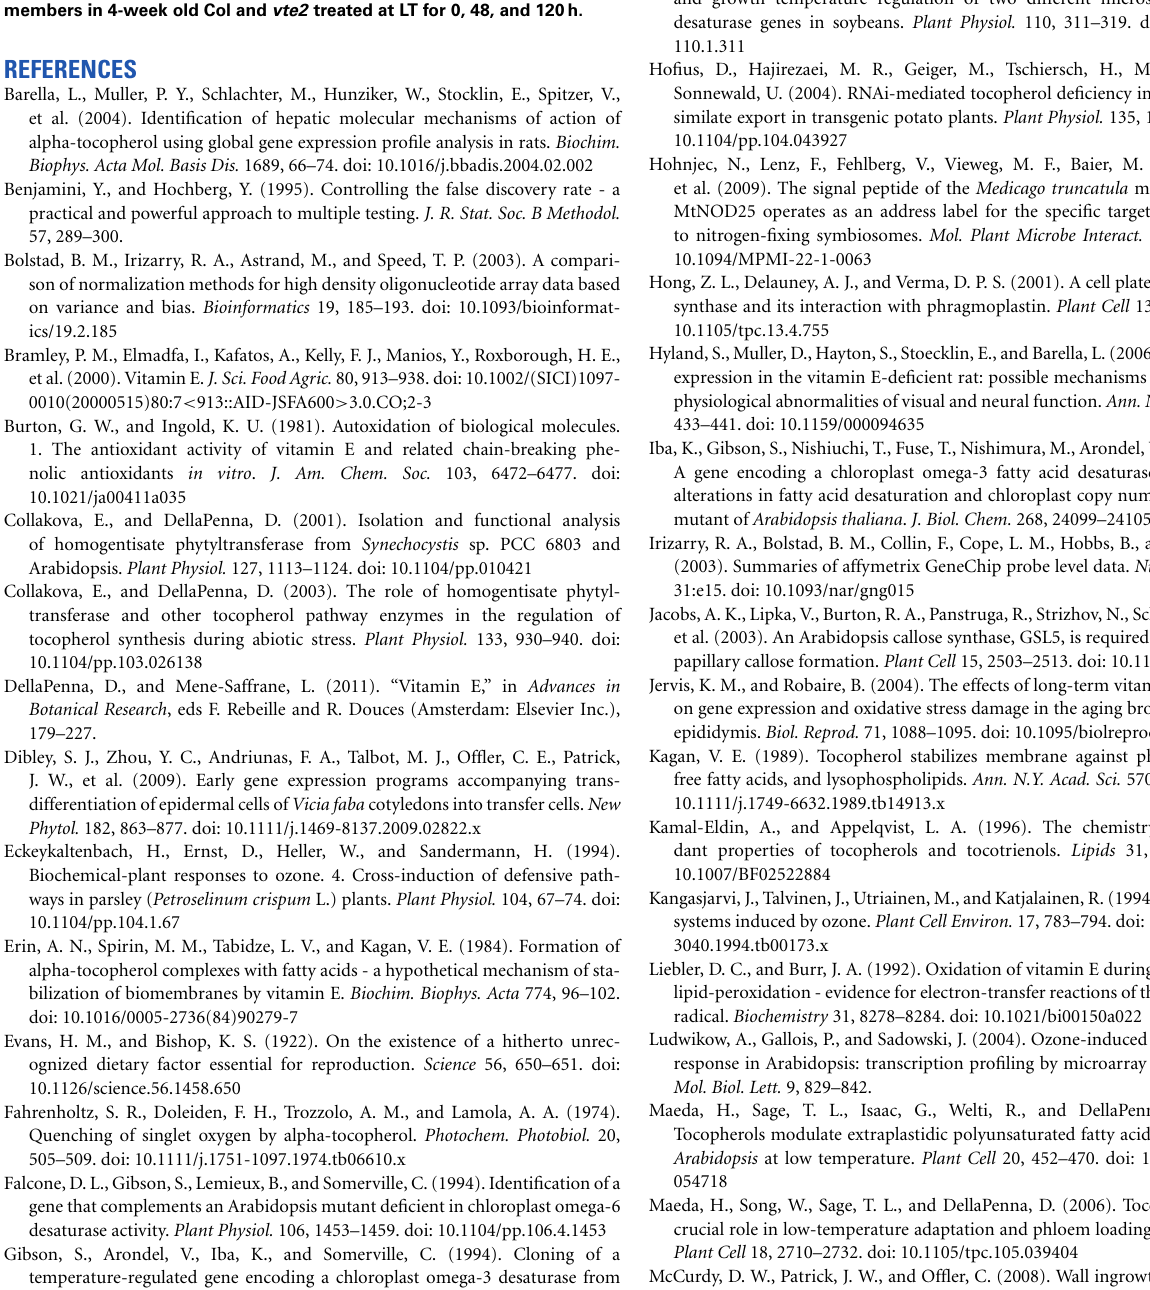
Supplemental Figure S1 | RNA degradation plot for the 18 microarrays. Supplemental Figure S2 | QC plot of 3’: 5’ ratios for control genes, percentage of present gene calls, and background levels of 18 microarrays. Supplemental Figure S3 | Box plots of all perfect match (PM) intensities of non-normalized (upper) and quantile normalized (bottom) 18 array data set. Supplemental Figure S4 | Whole plant phenotypes of the gsl5 vte2 mutant grown under permissive conditions for 4 weeks. Supplemental Figure S5 | Gene expression profiles for the 12 GSL family members in 4-week old Col and vte2 treated at LT for 0, 48, and